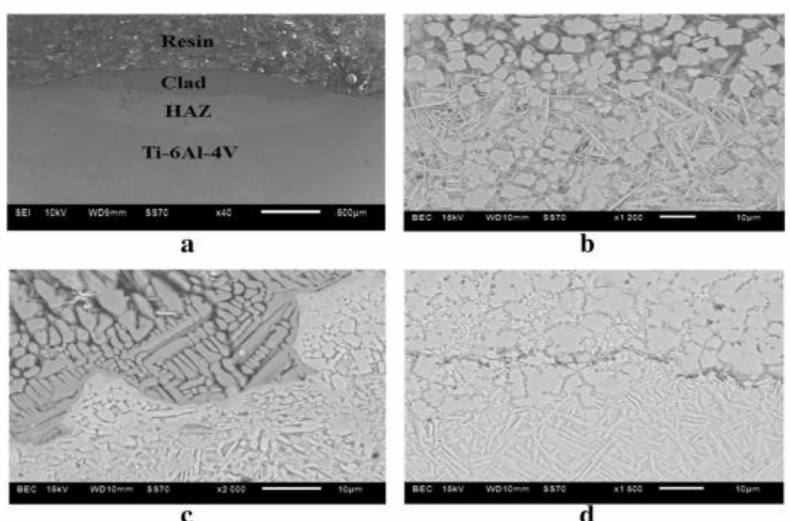
Figure 5. SEM images of hydroxyapatite (HAP) coatings after etching at 750 W ( a ), cross-section ( b ), cross-section clad and heat-affected zone ( c ), and cross-section heat-affected zone and Ti6Al4V substrate ( d ) [74]; published under open-access license by